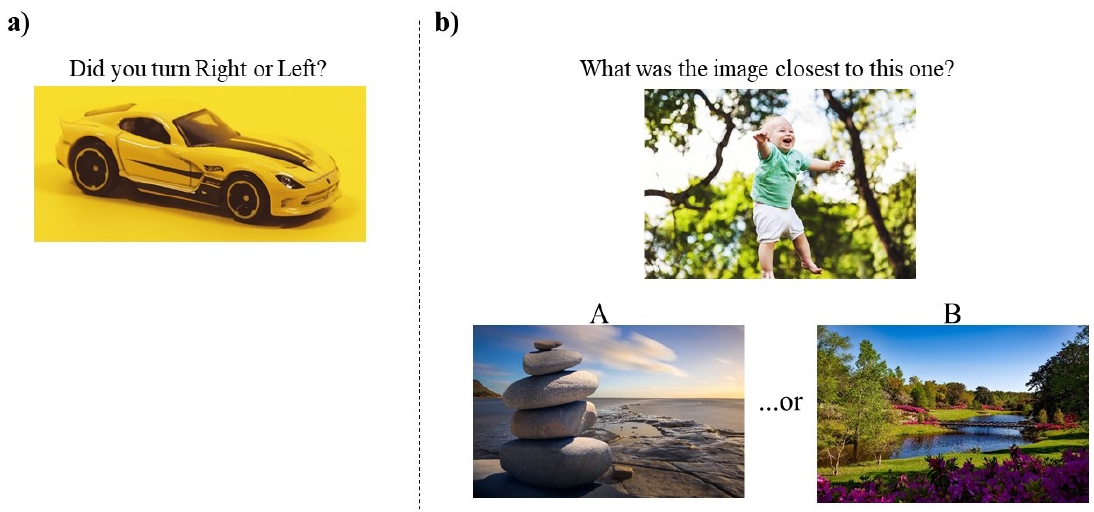
Figure 4. The figure depicts an example of stimuli used as trials in the route continuation task ( a ) and in the distance comparison task ( b ). The images in the figure are not those from the international affective picture system (IAPS), but they are copyright ‐ free images taken from https://www.pexels.com/it ‐ it/. They are present in this figure just for illustration purposes.